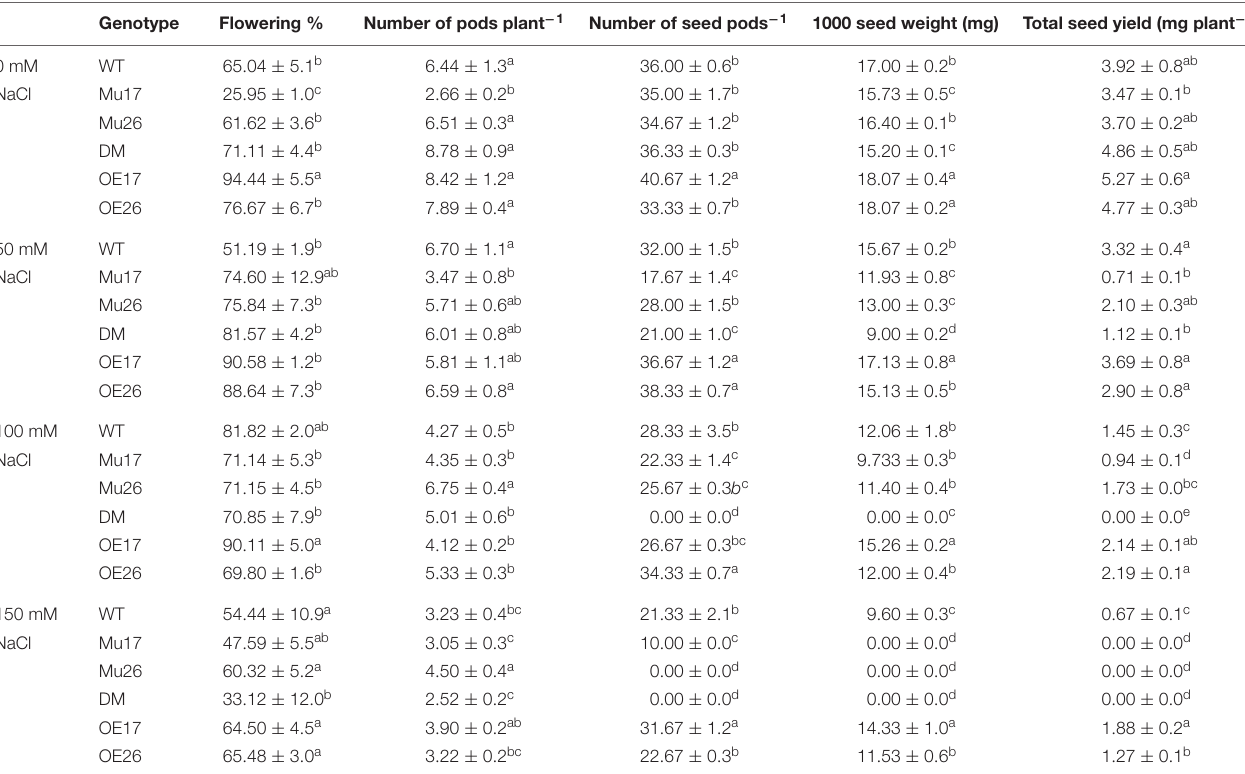
TABLE 5 | Means ( ± SE) of the yield and yield components in genotypes subjected to the NaCl concentrations. Genotype Flowering % Number of pods plant −